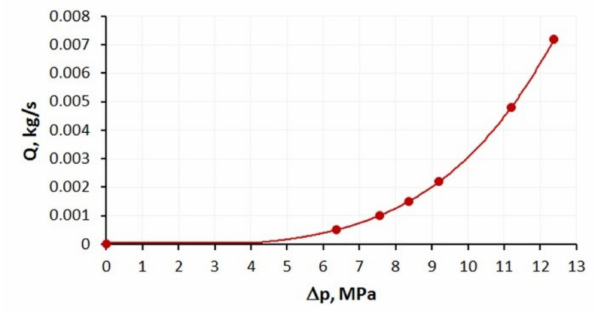
Figure 6. Die characteristics ( F slip = 0.064, e slip =